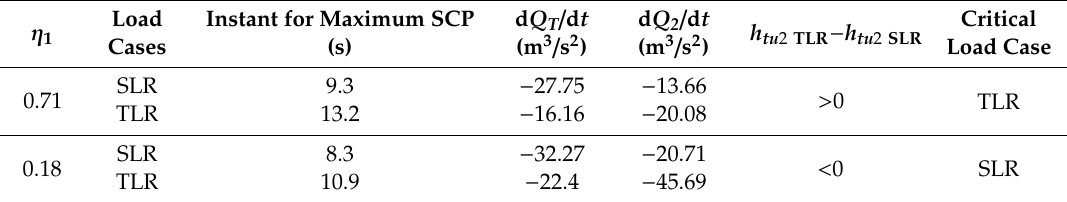
Figure 9. Discharge of the main and branch pipes versus time during SLR and TLR for η 1 = 0.71. Table 3. Change rate of discharge of main and branch pipes at the instant for maximum spiral case pressure